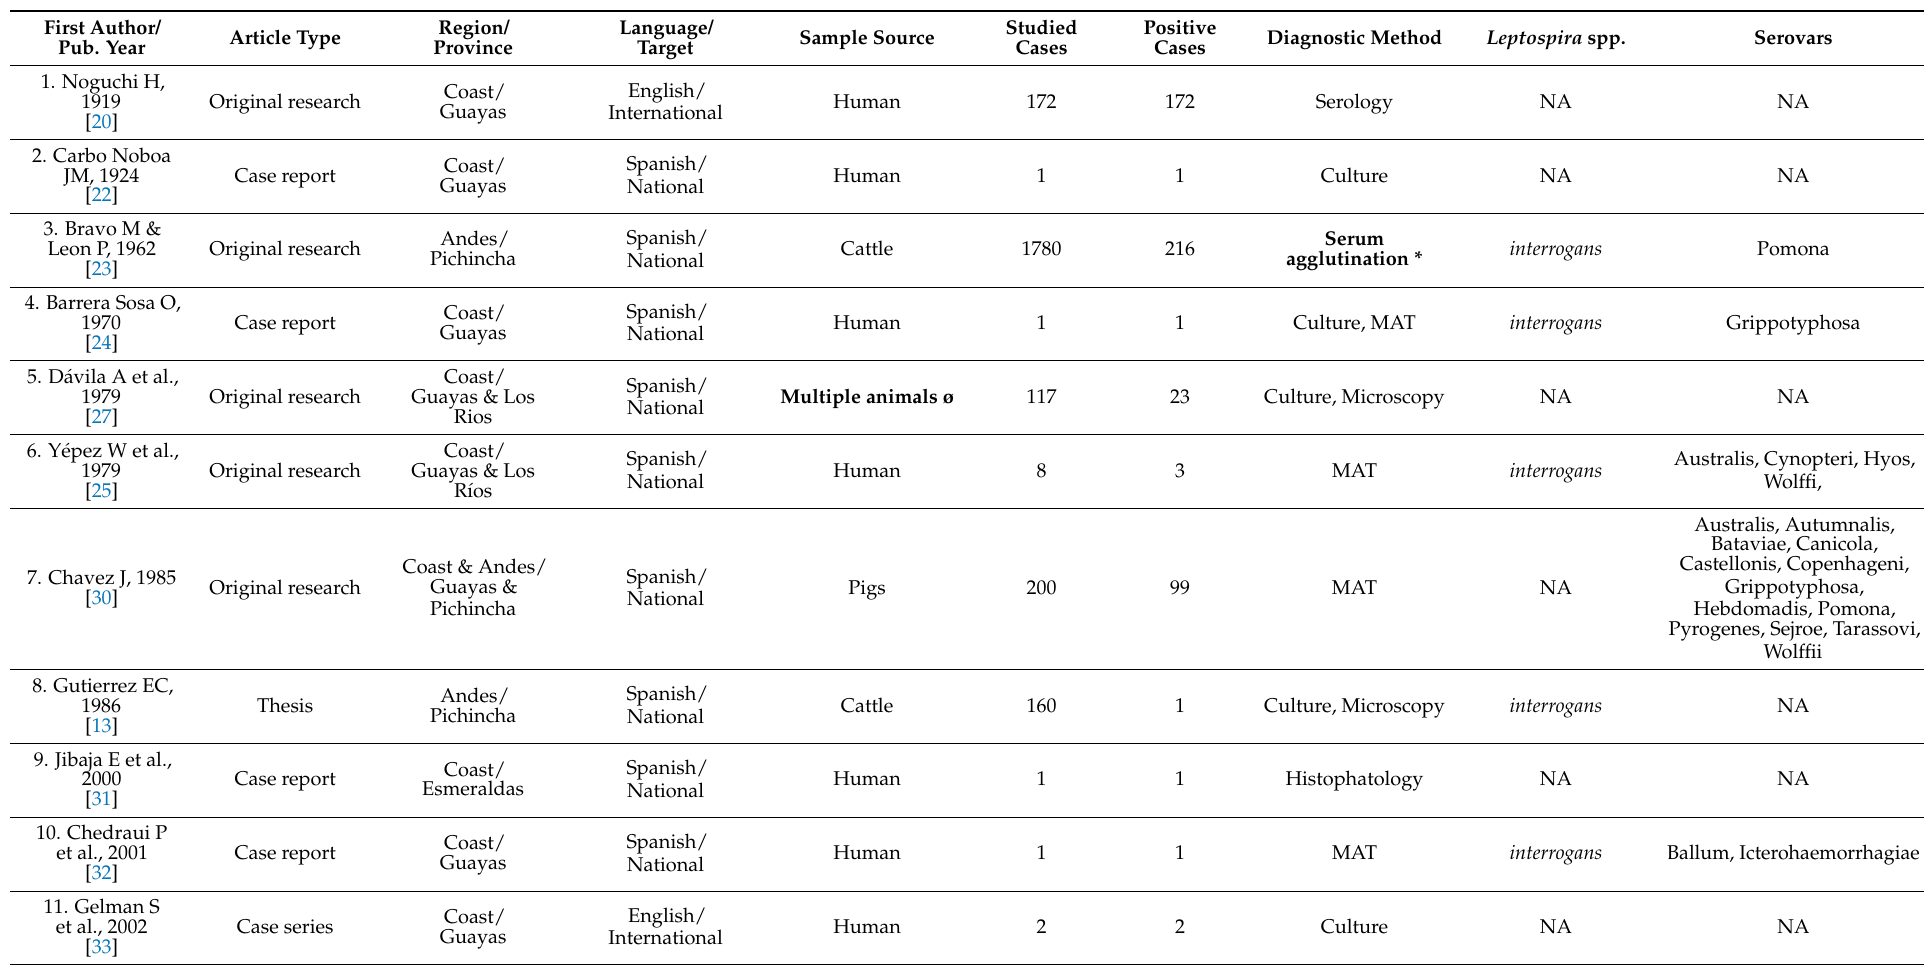
Table 1. Articles on Leptospira spp. and leptospirosis published in Ecuador since 1919 until 2021. Studies are alphabetically order considering the first author’s name. Details of specific studies (in bold) can be found at the end of the